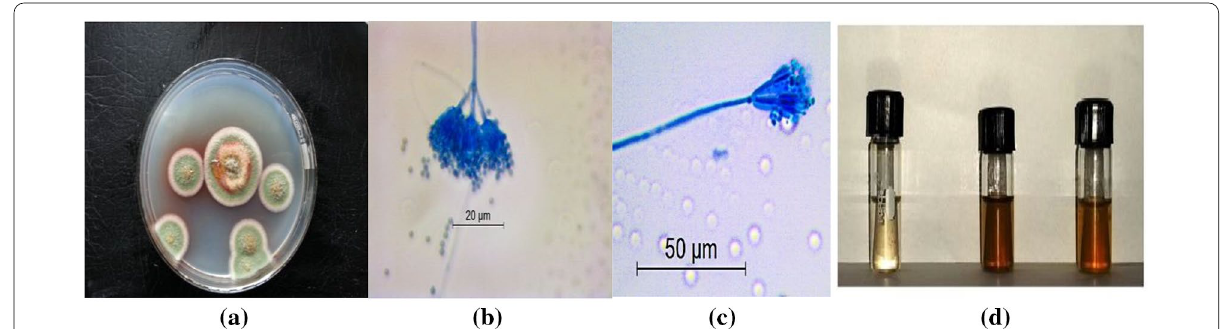
Fig. 1 a Talaromyces purpureogenus on solid agar medium. b , c T. purpureogenus microscopic image showing hyphae and spores. d Colour change of the reaction mixture after 24 h, 48 h, and 72